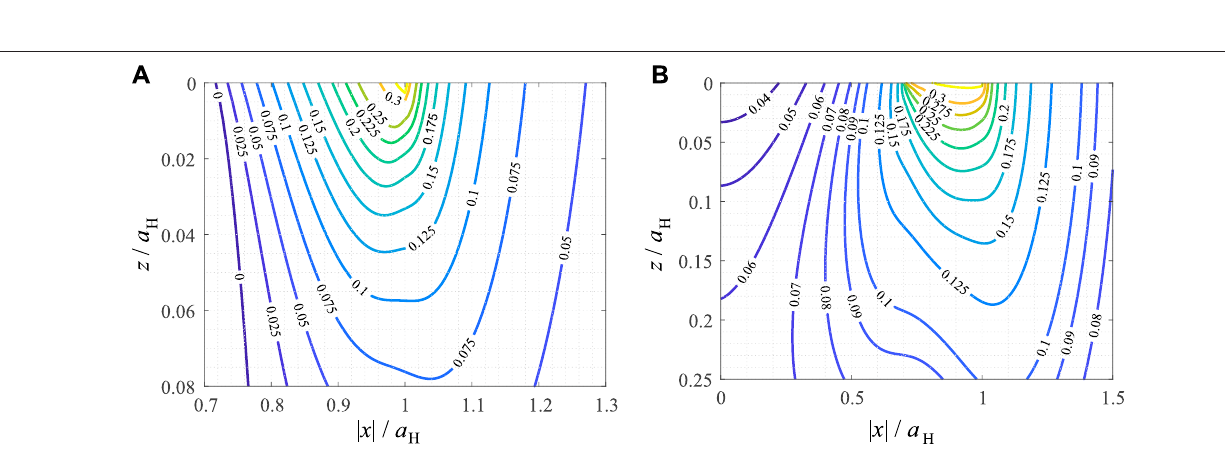
FIGURE 3 | Contour line diagrams of critical plane fatigue crack initiation criteria, normalized for their characteristic scales, in the loading plane for a partial slip axisymmetric parabolic contact under oscillating tangential load. (A) Smith-Watson-Topper parameter (B) Findley parameter.